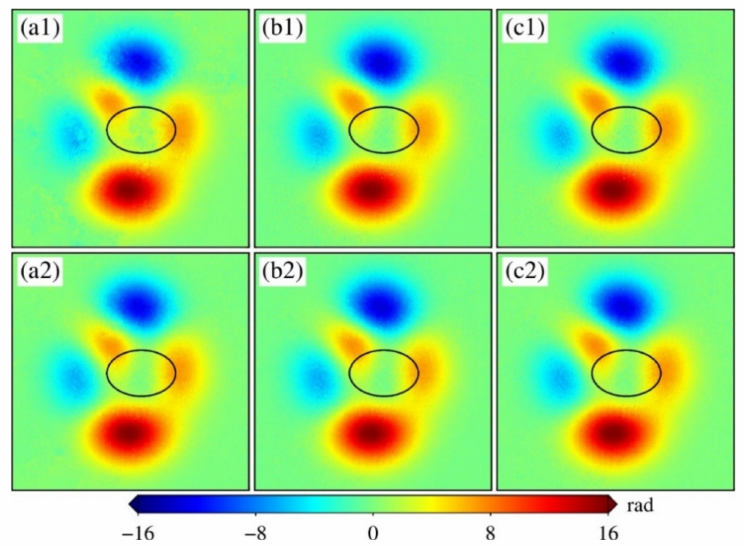
Figure 5. Comparison of unwrapped results of different methods: ( a1 ) no hierarchical WLS method; ( a2 ) WLS method for first-level points and HNCA method for second-level points; ( b1 ) PU results of no hierarchical mcf method; ( b2 ) mcf method for first-level points and HNCA method for second- level points; ( c1 ) PU results of no hierarchical snaphu method; ( c2 ) snaphu method for first-level points and HNCA method for second-level